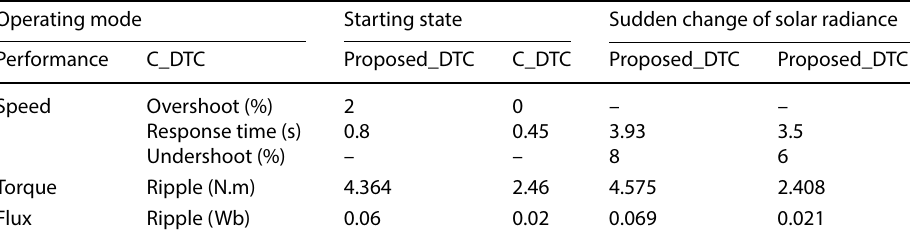
Table 7 Performance of PV system